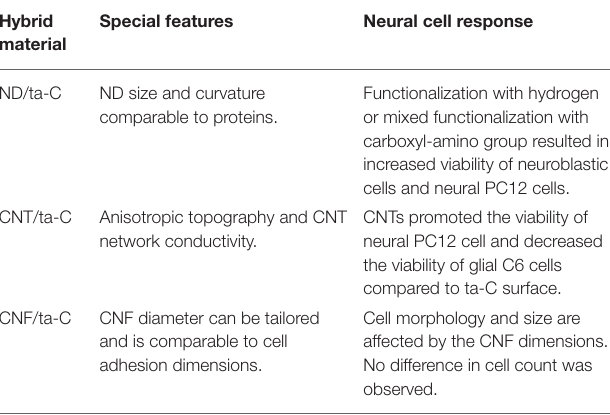
TABLE 1 | Special features and neural cell response on hybrid carbon